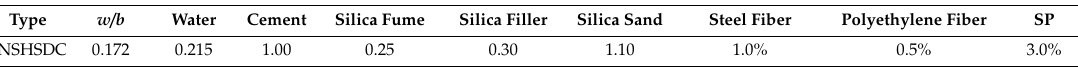
Table 2. Mixture proportion of NSHSDC.